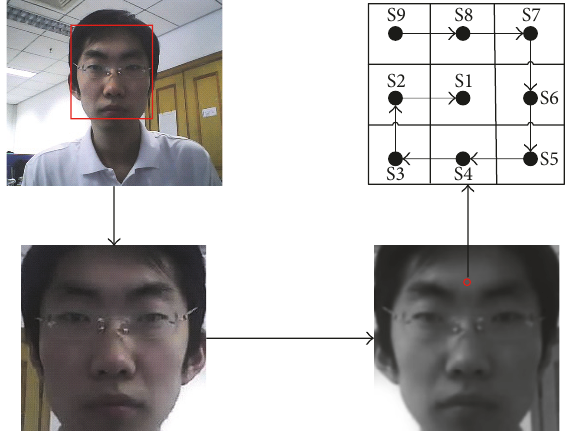
Figure 2: 3 ∗ 3 window pixel arrangement that delineates the processing